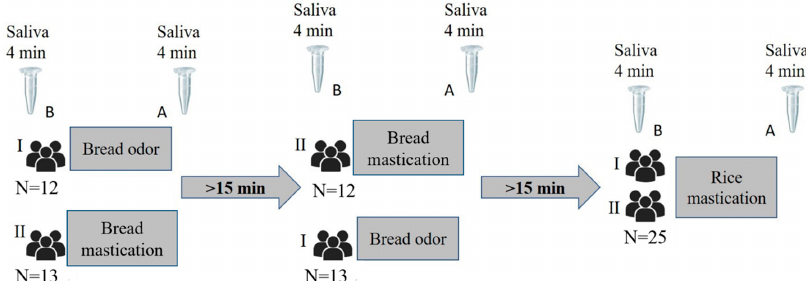
Figure 1. Schematic representation of practical experiment (I and II represent the two groups of participants, which collected saliva before (B) and after (A) each stimulus).